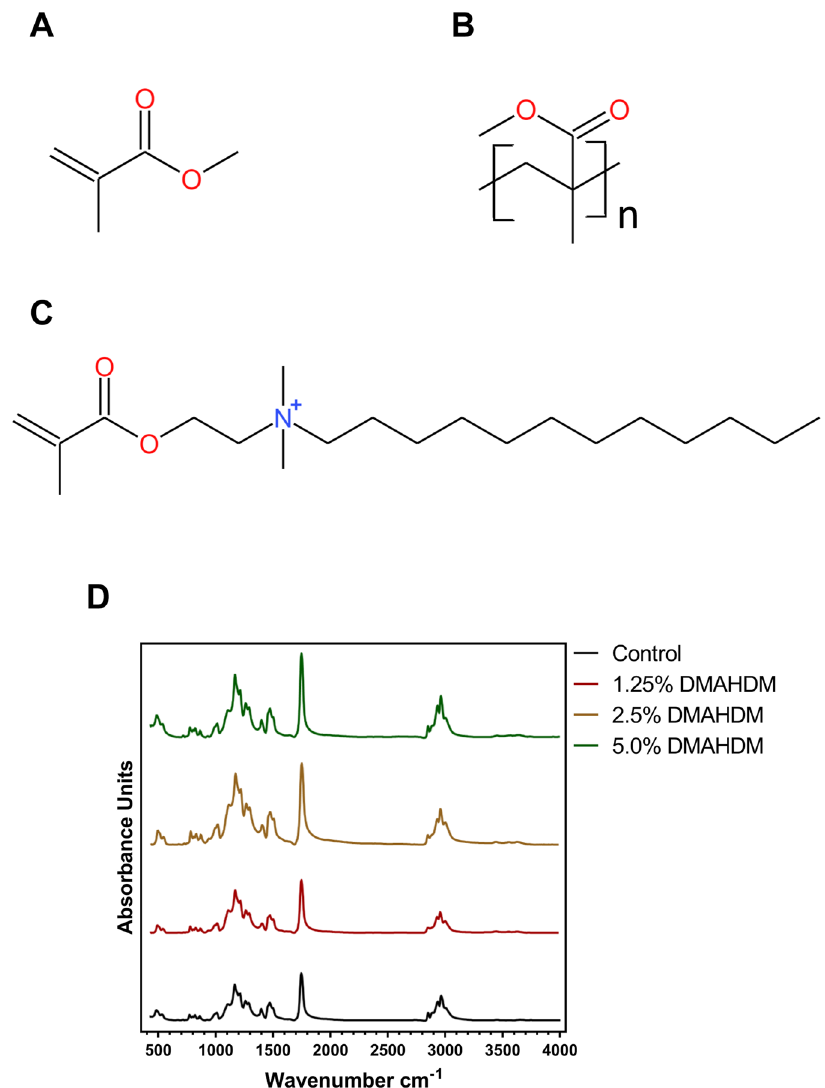
Fig. 2 Chemical components of the resins. A Chemical structure formula of MMA monomer; B polymethyl methacrylate (PMMA); C dimethylaminohexadecyl methacrylate (DMAHDM); D FTIR spectra of the self- cured